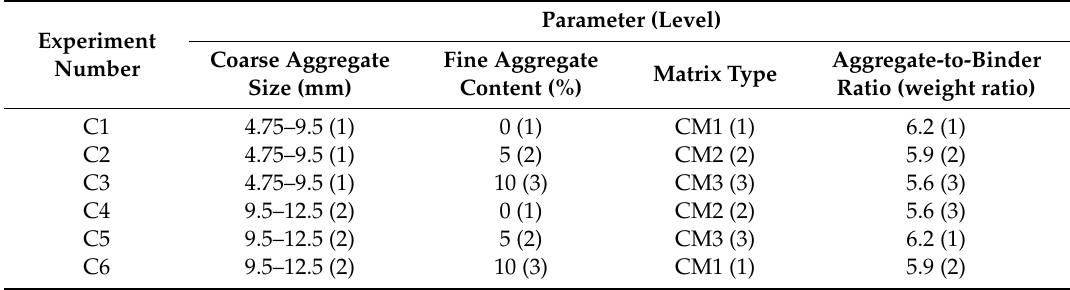
Table 5. L 9 (3 4 ) orthogonal array for pervious